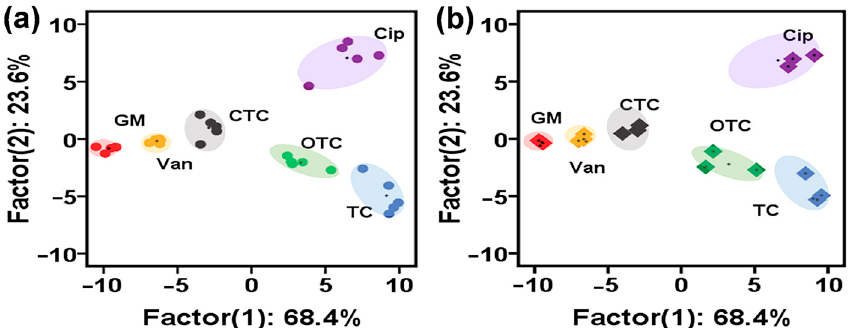
Figure 4. ( a ) LDA plot for the discrimination result with 95% confidence ellipses. Each point represents the response pattern for a single antibiotics sample against AuNCs-metal ions reaction systems. ( b ) Identification results of unknown antibiotics in river water.